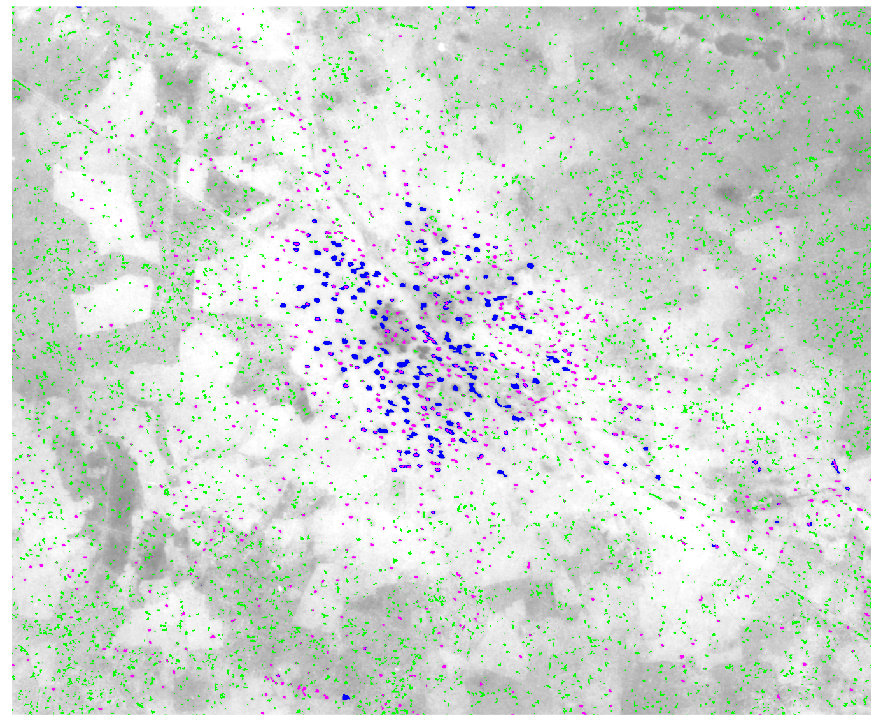
Figure 10. Final classification in 4 classes (after nested classification) from 12 granulometric levels. 6076 small spots (green), 791 medium size spots (magenta) and 237 larger spots (blue class). Guileyni, 1975.